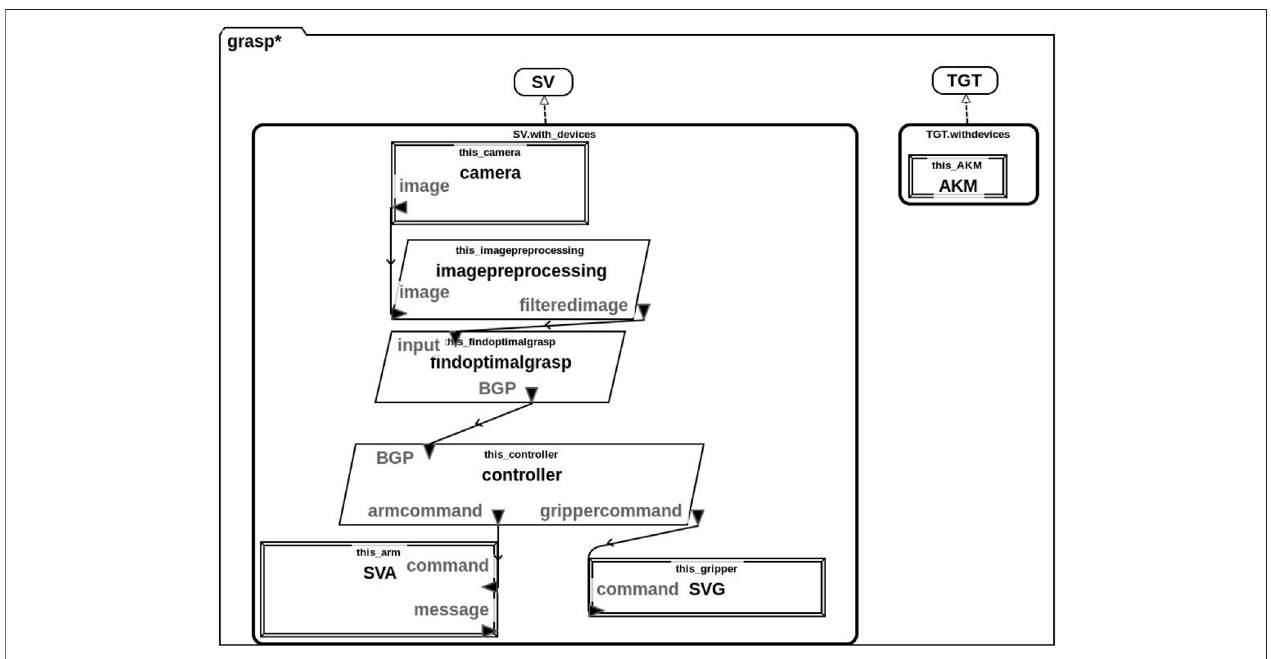
FIGURE1| AADL modelofthesystemcomprising boththehardwareand softwarecomponentsoftheservicevehicle( SV )andthetarget( TGT ).The SV containsa camera ,arm( SVA )andgripper( SVG )ashardwarecomponents.Itssoftwarecomponentsareusedtopre-processtheinputimage( imagepreprocessing ),calculate the optimal grasp ( fi ndoptimalgrasp) and control the arm and gripper ( controller ). Arrows indicate data fl ow and variable names are given.